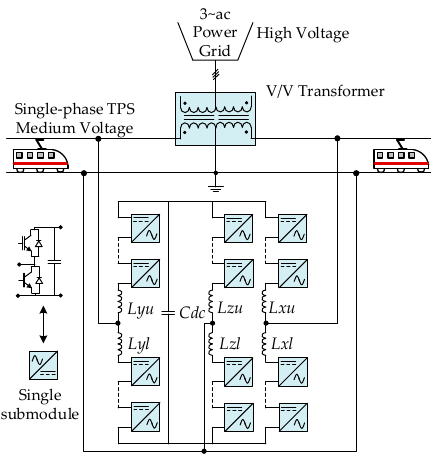
Figure 29. Rail power conditioner (RPC) based on modular multilevel converter (MMC).